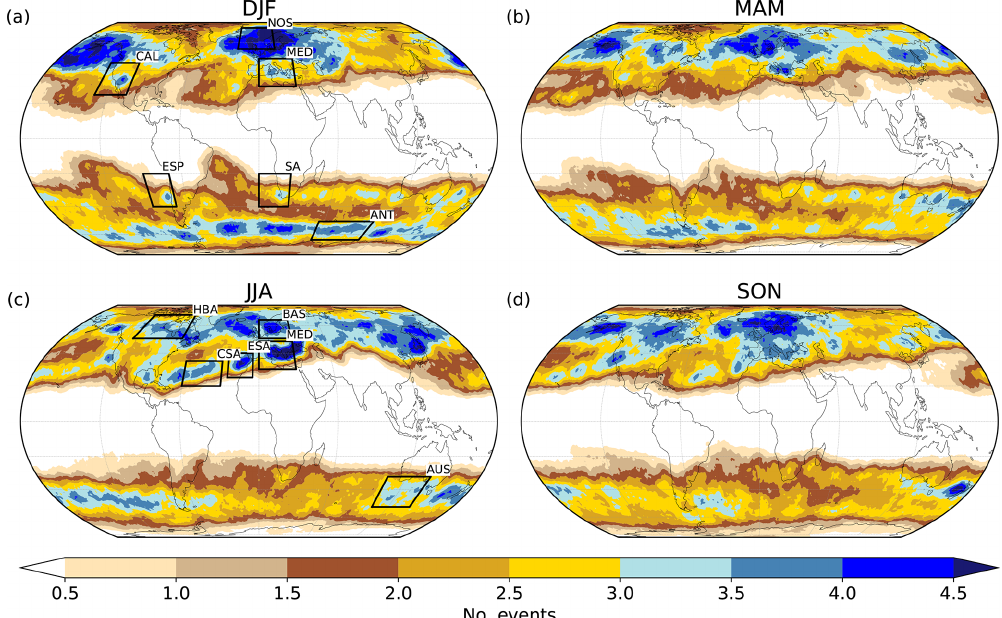
Figure 4. Seasonal average number of PV cutoff genesis events within a distance of 500km in (a) DJF, (b) MAM, (c) JJA, and (d) SON. The location of a genesis event is determined by the center of the first PV cutoff of a track. Black boxes mark the genesis regions investigated in Sect.